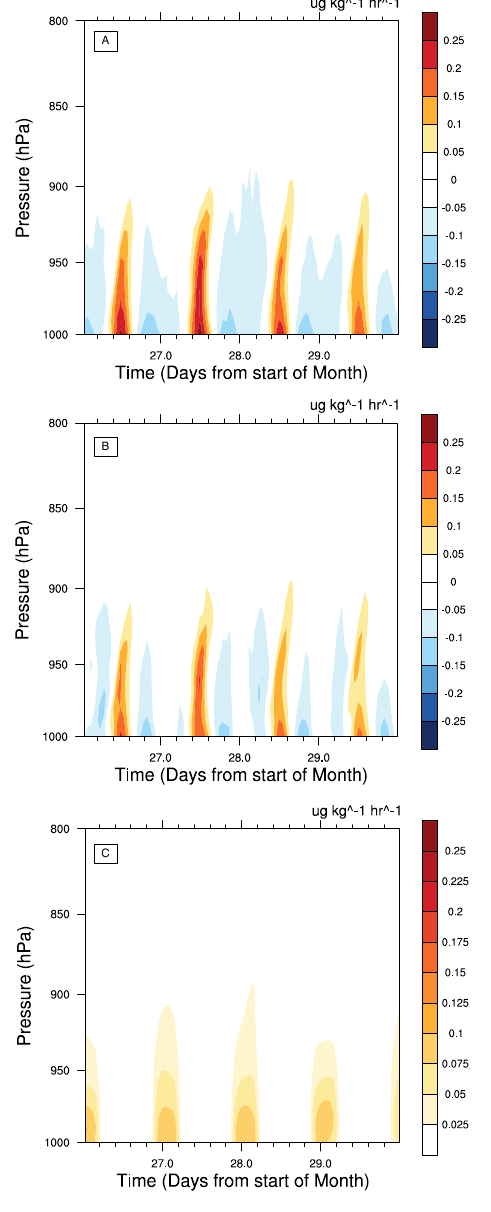
Figure 13. Domain-averaged tendencies in total nitrate mass load- ings. ( a ) and ( b ) show the incremental change in the domain mean total nitrate (aerosol nitrate plus gas-phase HNO 3 ) in µgkg − 1 for the “het off” and “het on” scenarios, respectively. (c) shows the domain mean of the integrated uptake rate of N 2 O 5 (plotted as po- tential aerosol nitrate mass loading, without consideration of loss to the ClNO 2 pathway).